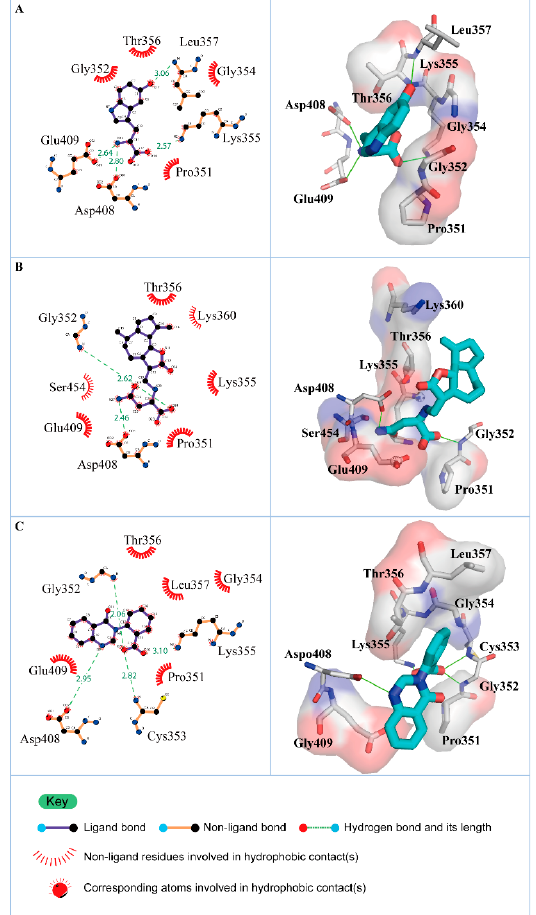
Figure 4. Hydrophobic contacts between residues of paraplegin and ( A ) 5-hydroxy- L -tryptophan; ( B ) saussureamine C; and ( C ) 3-(2-carboxyphenyl)-4(3 H )-quinazolinone.